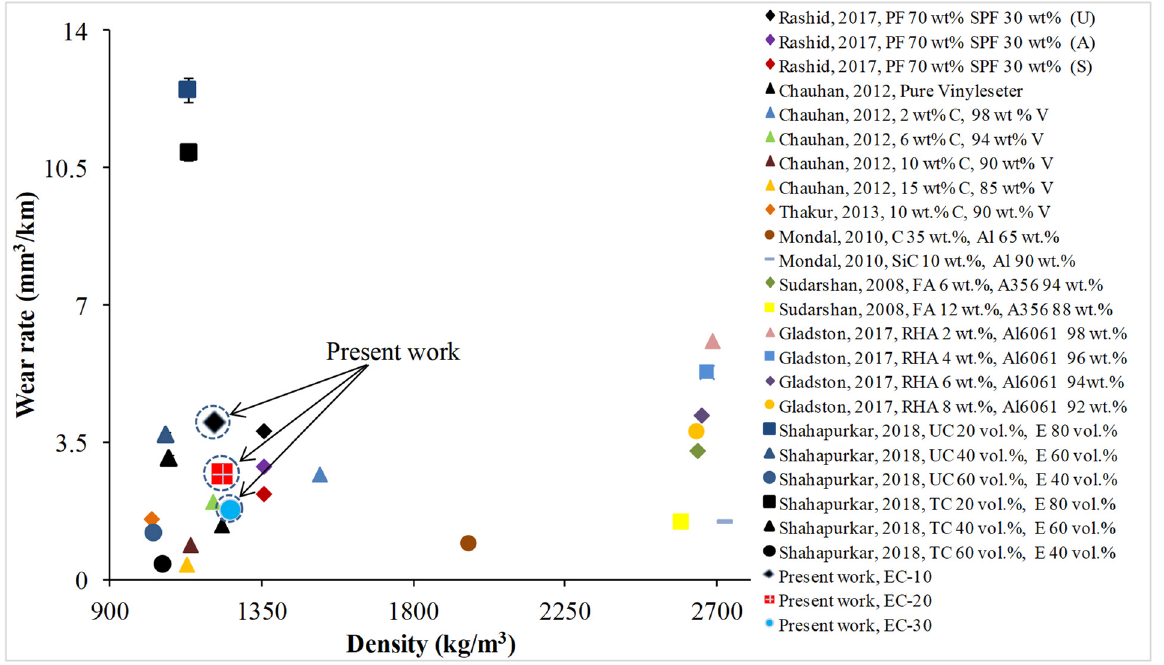
Figure 11. Plot of density against wear rate observed for different composites [12,47–51]. PF: phenolic resin; SPF: sugar palm fiber; U: untreated; A: alkali-treated; S: seawater-treated; C: cenosphere; V: vinyl ester; RHA: rice husk ash; FA: fly ash; SiC: silicon carbide; Al: aluminum; A356: aluminum–silicon alloy; Al6061: hardened aluminum alloy; UC: untreated cenosphere; TC: treated cenosphere.